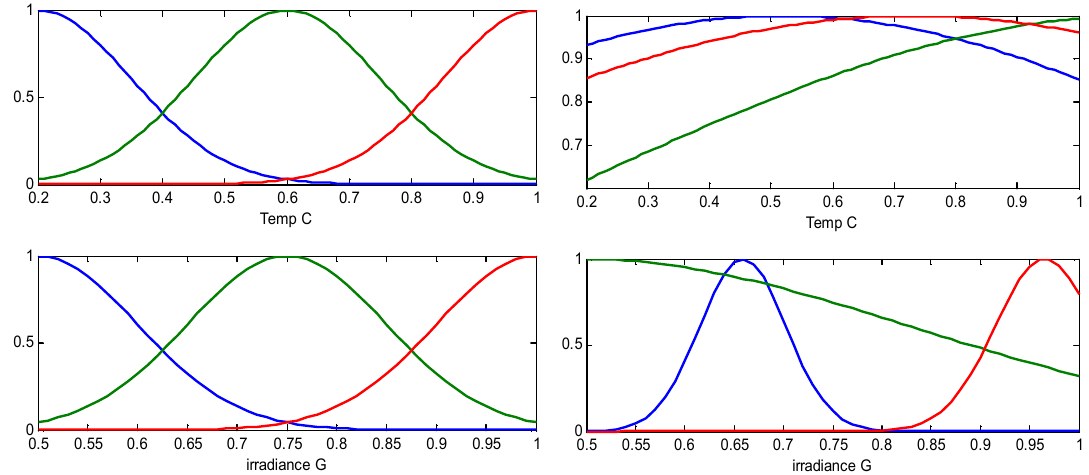
Figure 8. Membership functions of the FFN controller before and after training.